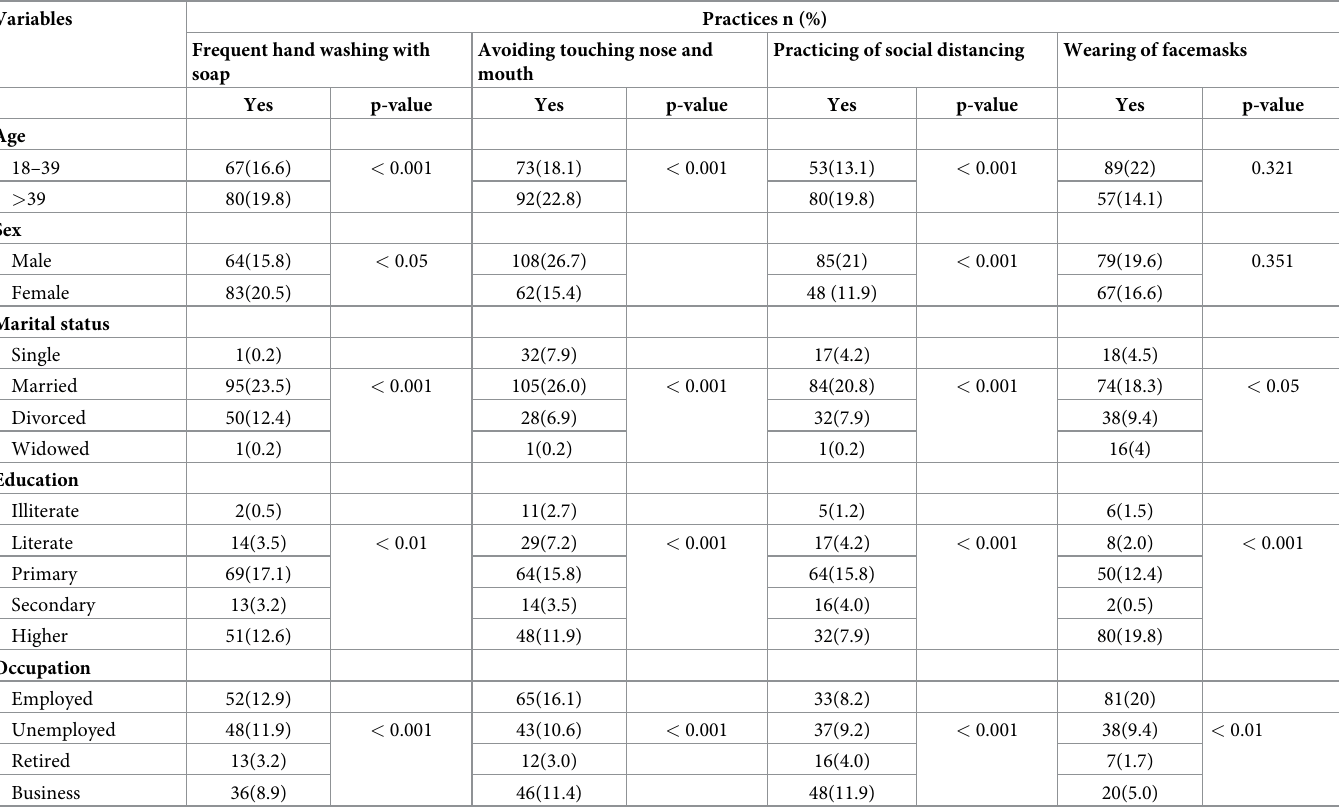
Table 7. Bivariate analysis to determine the association of practices with socio-demographic characteristics of the respondents towards COVID-19 (n =